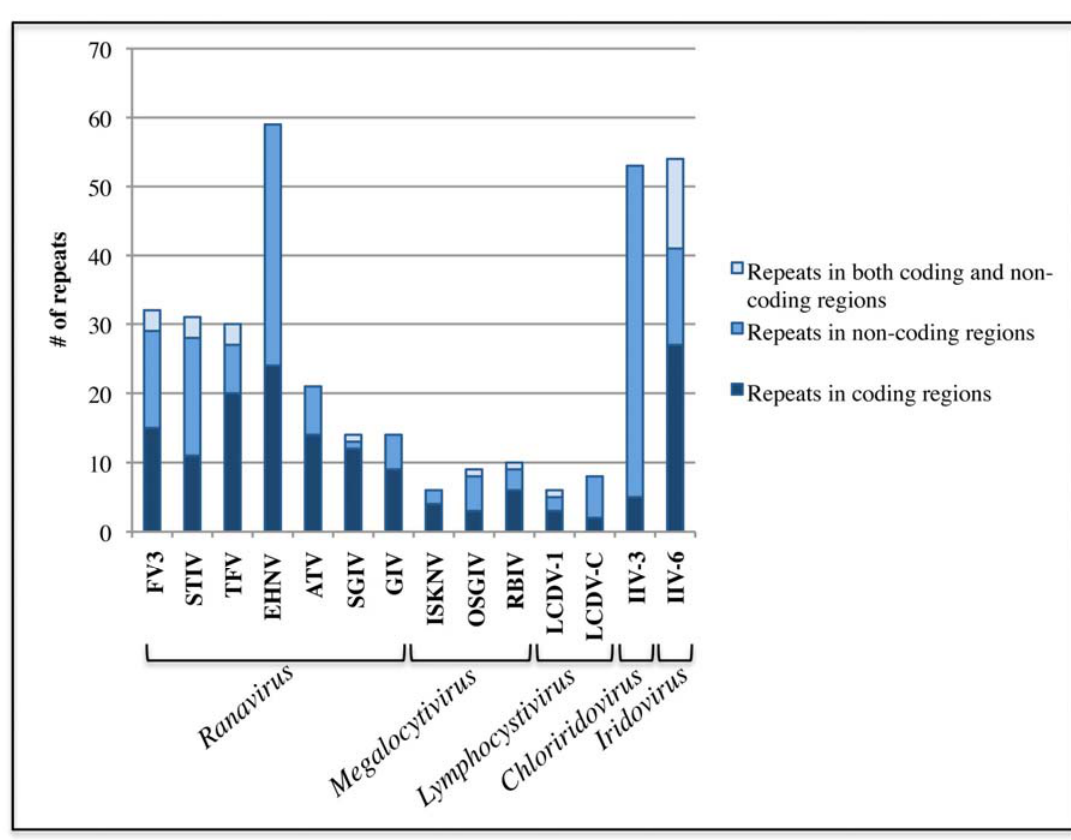
Figure 3. Repeats in the family Iridoviridae vary in number and dispersion throughout the genomes. Tandem repeats were identified using a tandem repeat finder [46]. For each sequenced iridovirus, the number of tandem repeats found within coding regions are shown in dark blue, repeats found within non-coding regions are shown in blue, and repeats that transverse between both coding and non-coding regions are shown in light blue. The height of the bar represents the total number of repeats found in the